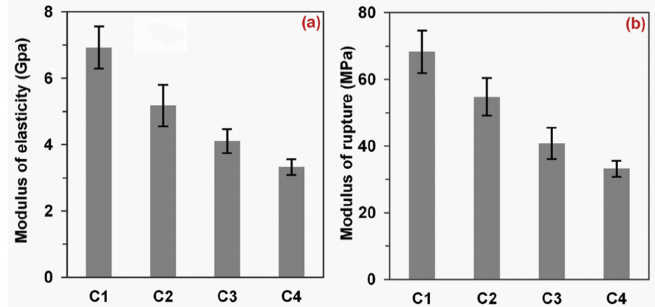
Figure 3. Modulus of elasticity ( a ) and rupture ( b ) of Fiber/polyester (C1), Fiber/PAC10/polyester (C2), Fiber/PAC20/polyester (C3), and Fiber/PAC30/polyester (C4) composites.